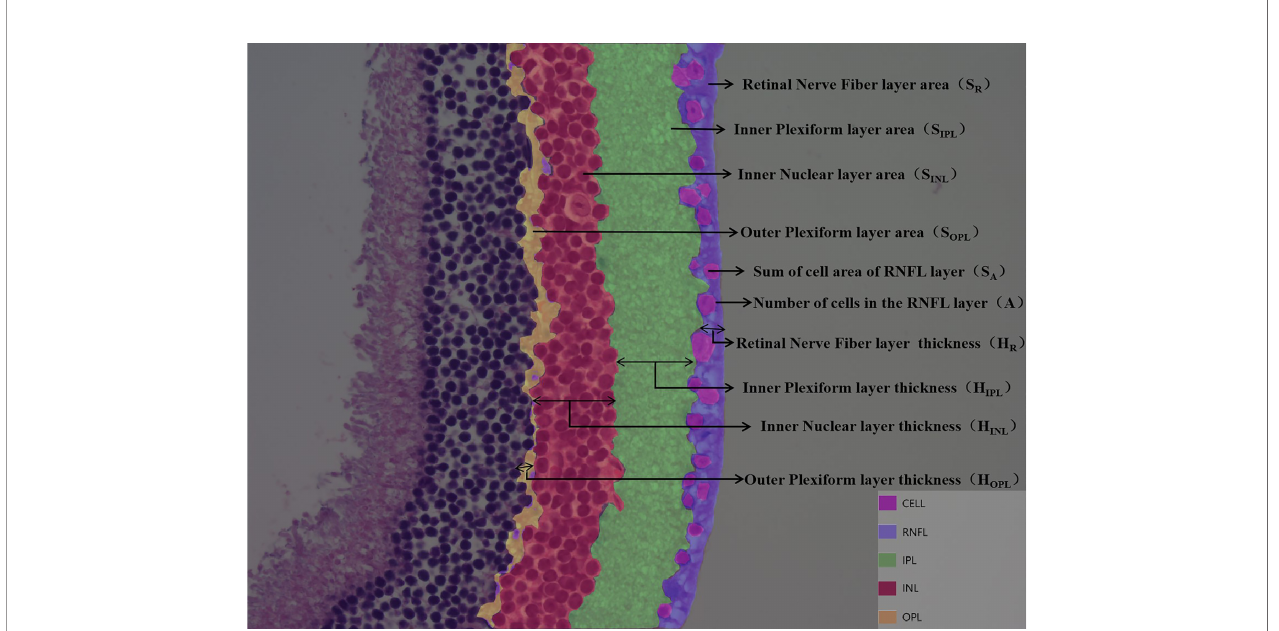
FIGURE 2 | Customize parameters for each layer of retina. DR is divided into non-proliferative and proliferative lesions, of which non-proliferative lesions occur fi rst, and their lesion sites are mainly located in the retinal nerve fi ber layer (RNFL), inner plexiform layer (IPL), inner nuclear layer (INL), and outer plexiform layer (OPL). Based on this feature, we arti fi cially de fi ned the RNFL area as S R and the thickness as H R ; the IPL area as S IPL and the thickness as H IPL ; the INL area as S INL and the thickness as H INL ; the OPL area as S OPL and the thickness as H OPL ; the ganglion cell count as A; and the total ganglion cell area as S A